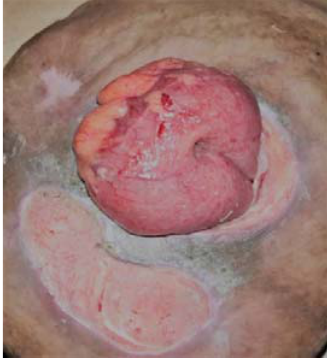
Figure 2. Hernia after partial reduction